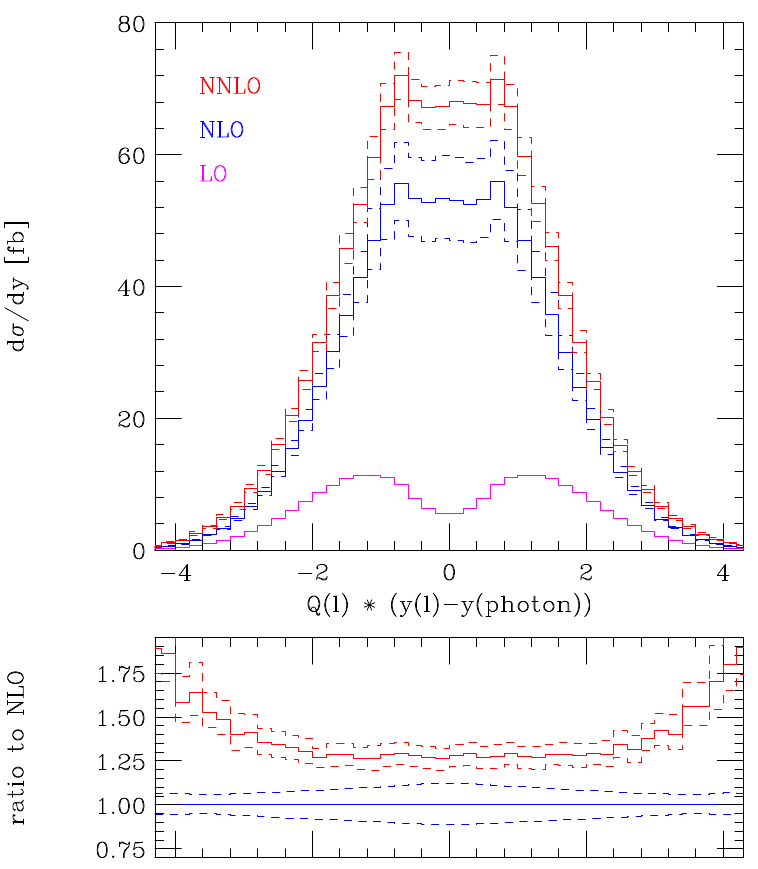
Figure 7 . Signed rapidity difference between the lepton and the photon at 13 TeV. The NNLO and NLO histograms display the error estimates, obtained via a 9-point scale variation, and the lower panel displays the ratio of the NLO and NNLO predictions to the central NLO